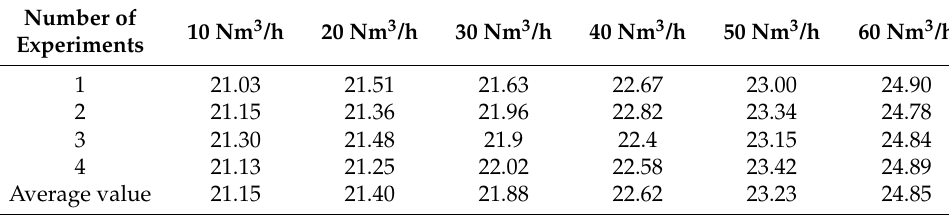
Table 3. Liquid particle size in Case 1 at M 1 ( µ m).